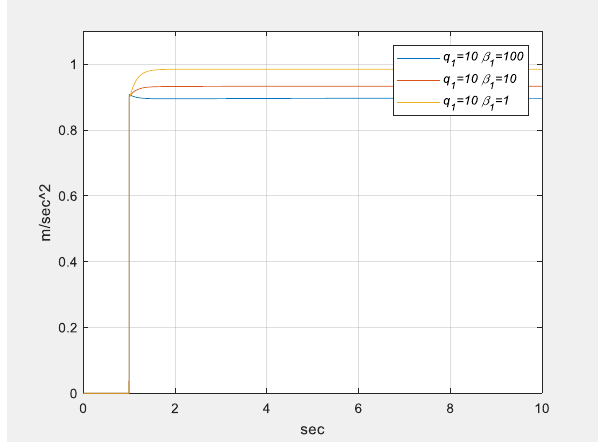
Figure 15. Verification of the influence of specific force tracking on angular velocity . influence of β 1 on specific force f B sx .